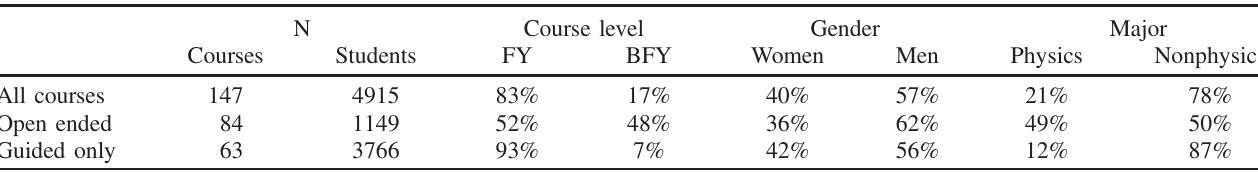
TABLE II. Demographic breakdown of the full data set, as well as the subset of courses with open-ended activities and those with only traditional guided lab activities. Number of courses refers to the number of distinct courses, and percentages represent the percentage of students rather than the percentage of courses. For major and gender demographics, the totals may not sum to 100% as some students did not complete these questions or selected “ other ” as their gender.